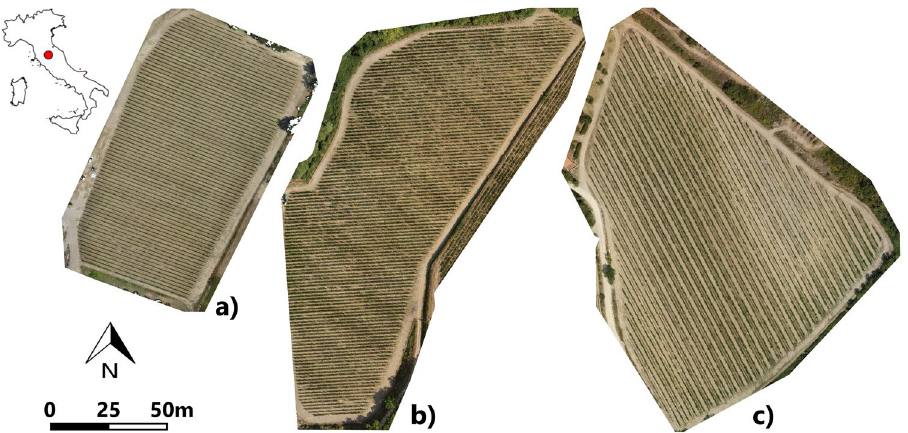
Figure 1. Experimental vineyards: Caggio ( a ), Belvedere ( b ) and Solatio ( c ) sites. The images were created using RGB imagery acquired by UAV during the flight campaign in the 2017 season.